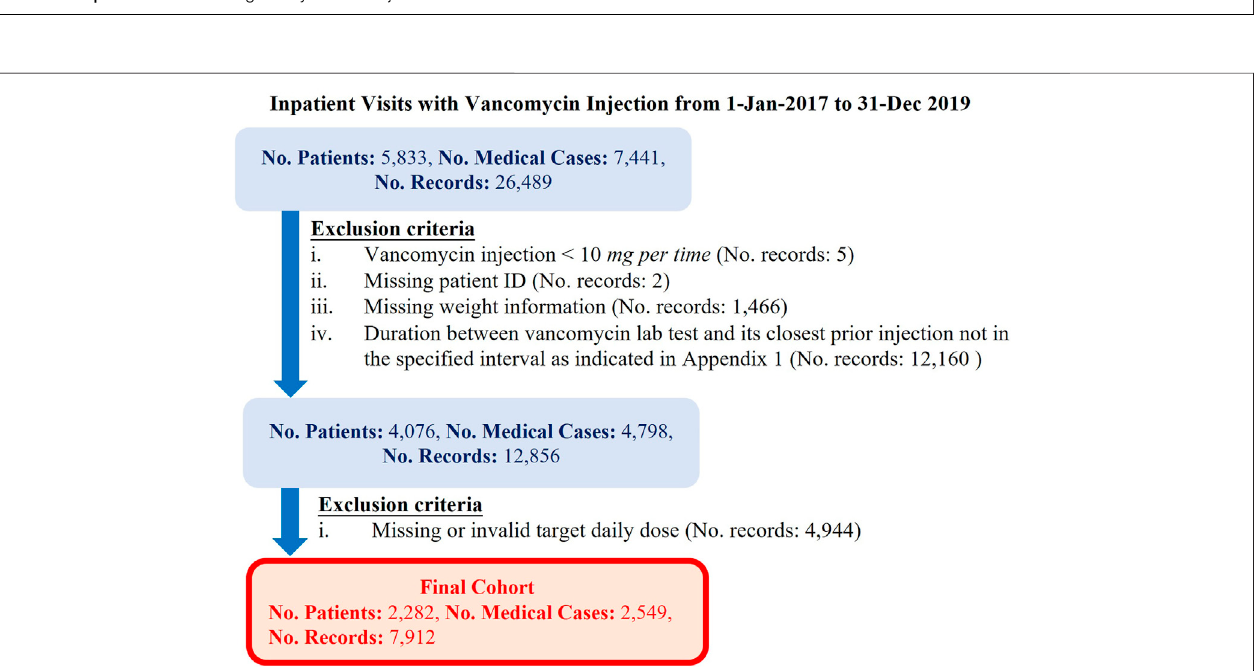
FIGURE 1 | De fi nition of the target daily dose of injection.